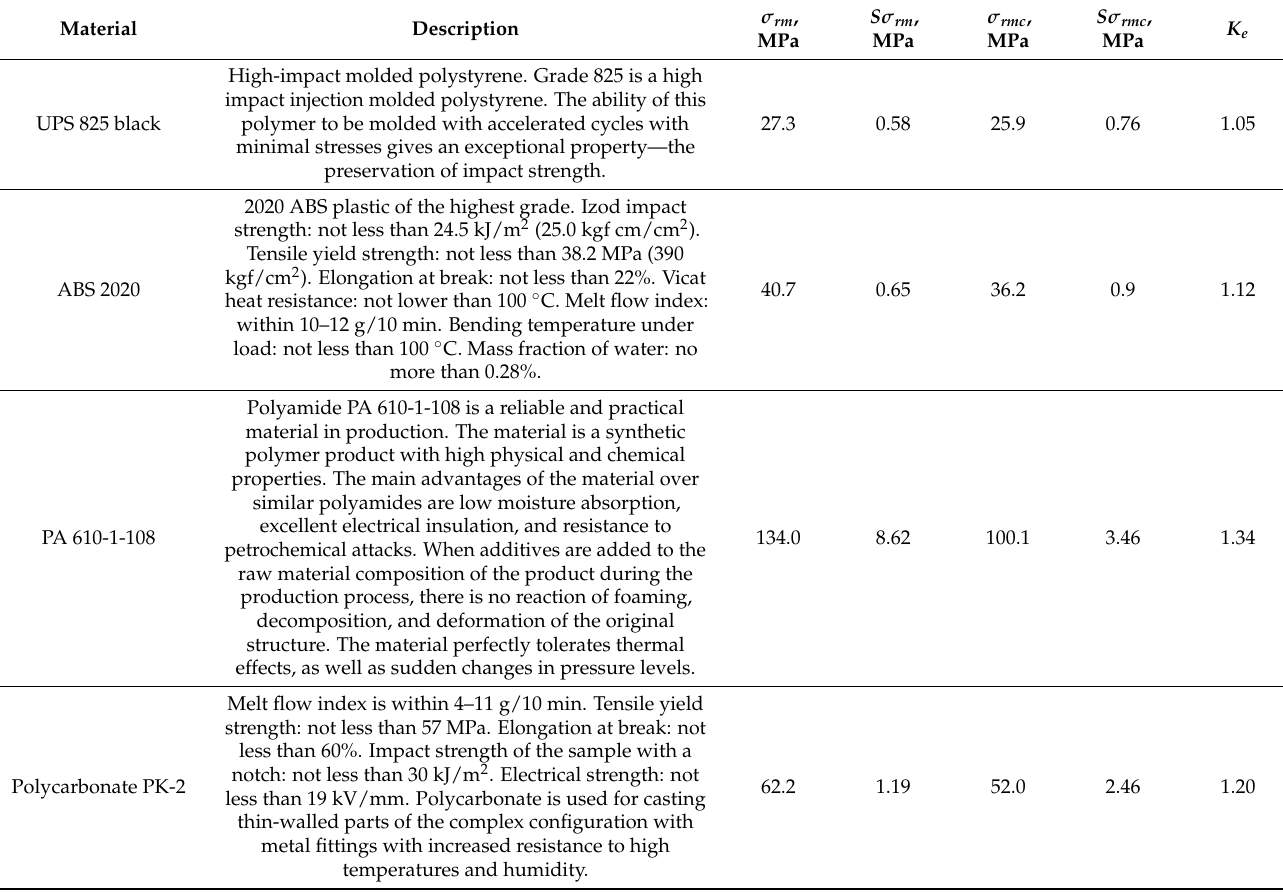
Table 2. Effective Stress Concentration Factor for Thermoplastics.